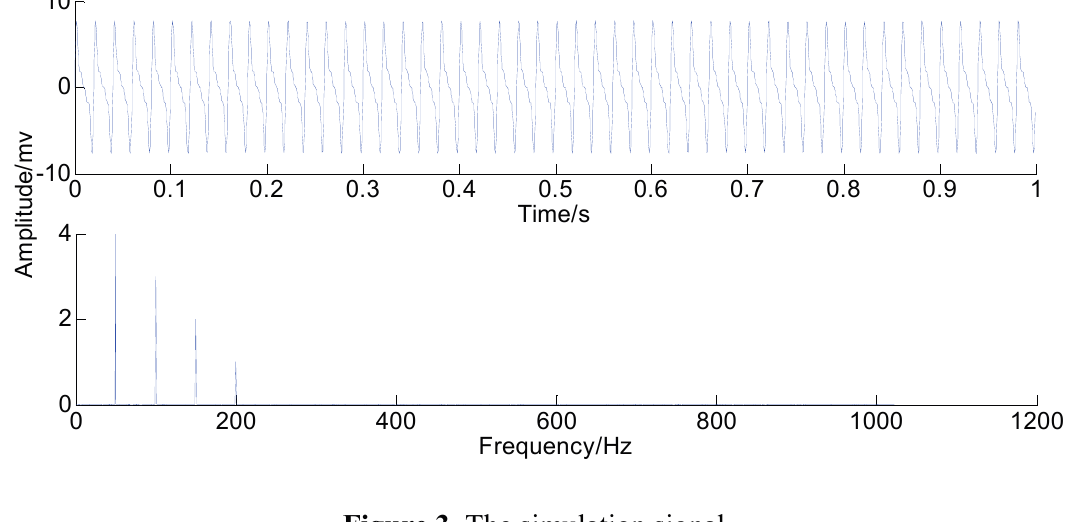
Figure 3. The simulation signal.